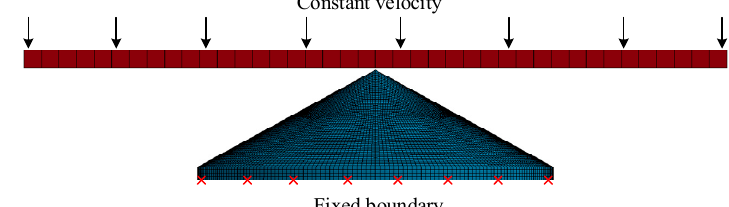
Figure 7. The model of ice-cone crushing tests.